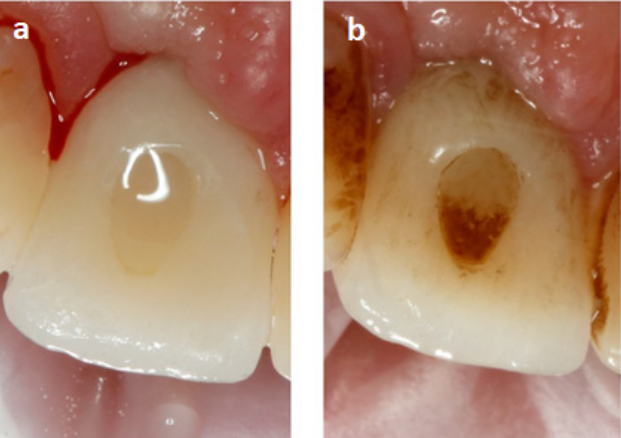
Figure 1. Intraoral photo showing the all-ceramic crown on the implant in the tooth position 11 after the professional oral cleaning ( a ) and 1.5 years later ( b ). Palatine surface view.